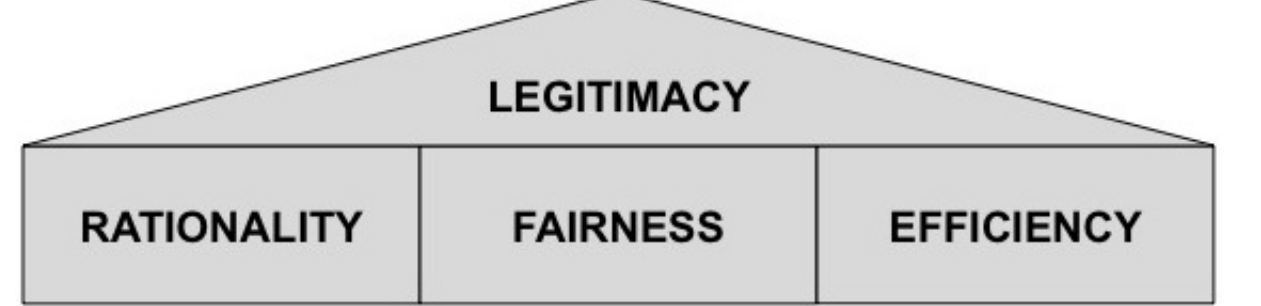
Figure 2. Requirements for legitimate decision